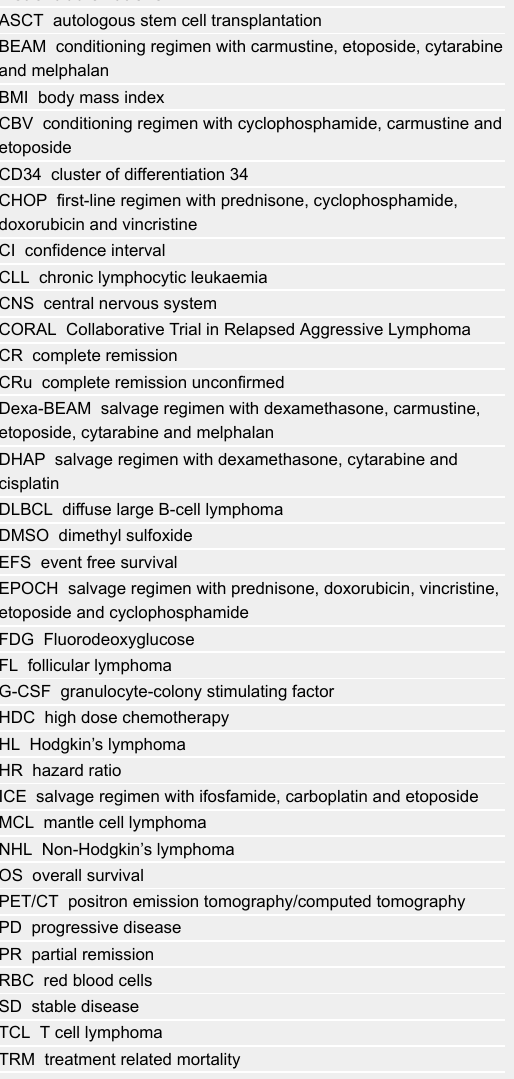
ASCT autologous stem cell